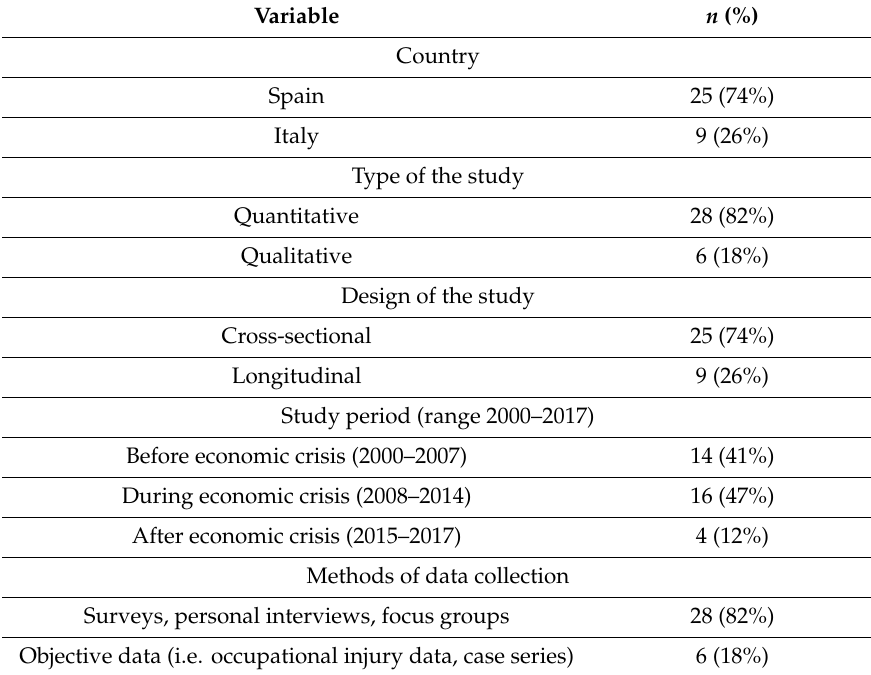
Table 1. Summary of the main features of the 34 studies included in the scoping review about occupational health and safety of immigrant workers in Italy and Spain